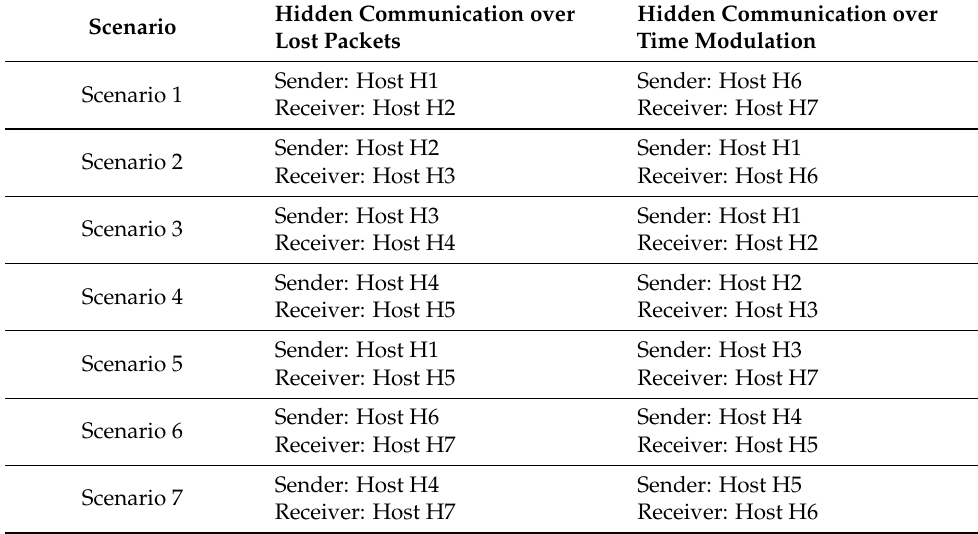
Table 2. Setup of pairs of sender-receiver for generation of hidden communication simulations.